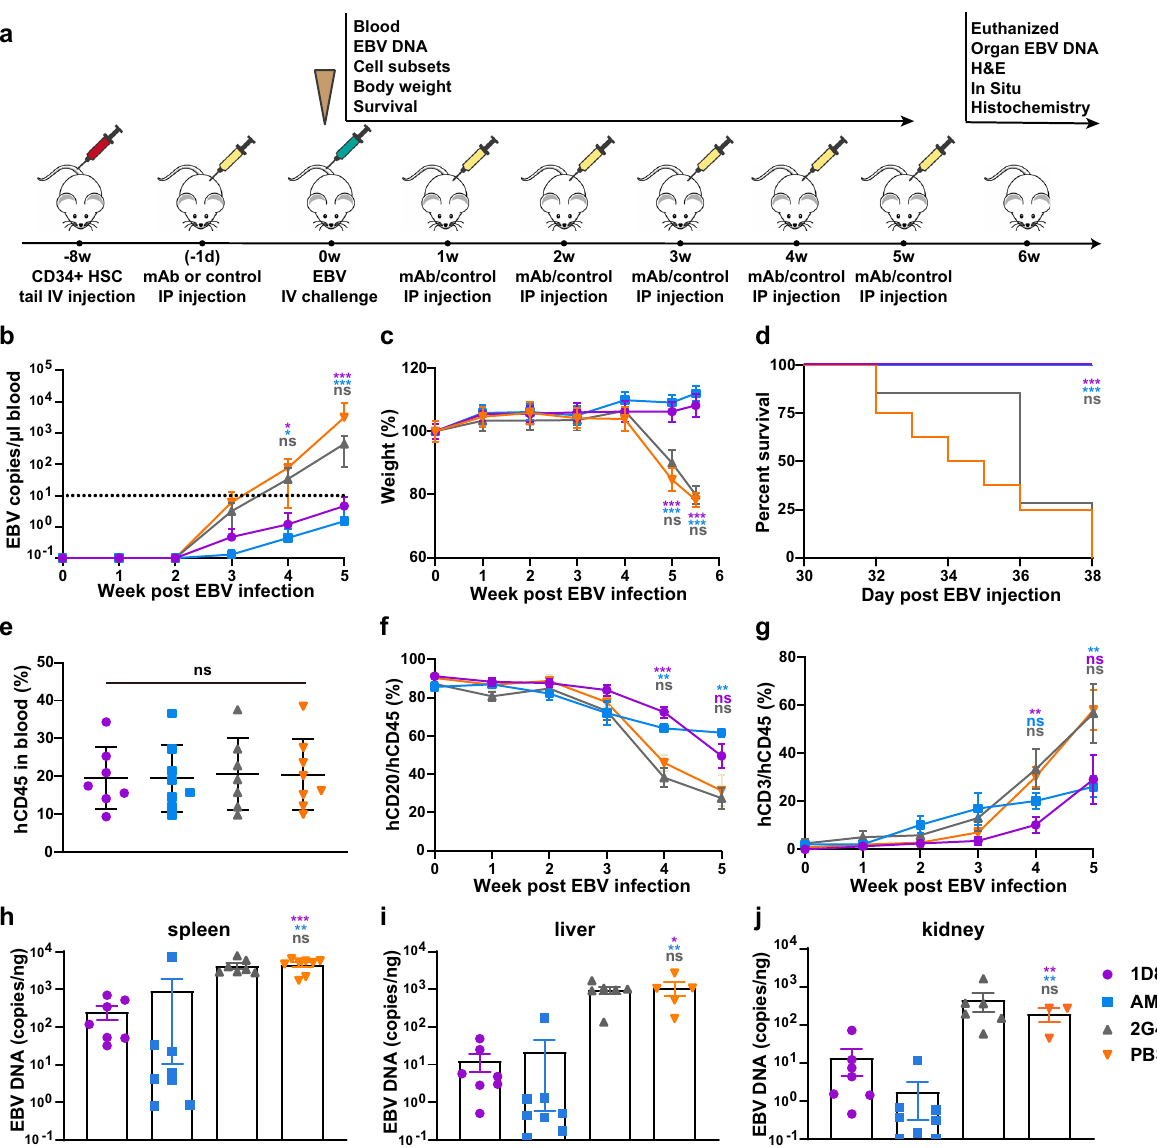
Fig. 2 Protective ef fi cacy of 1D8 against lethal EBV challenge in humanized mice. a Timeline for engrafting CD34 + human hematopoietic stem cells (HSC), antibody administration, viral challenge, and monitoring for various biological and clinical outcomes. 400 μ g of 1D8 ( n = 7), positive control AMMO1 ( n = 8), negative control 2G4 ( n = 7), or PBS ( n = 8) were administered to the humanized mice via intraperitoneal injection either 24 h prior to or weekly for 5 weeks after intravenous challenge with Akata EBV. b EBV DNA in the peripheral blood, ( c ) body weight, and ( d ) survival were monitored weekly. The percent changes in ( e ) hCD45 + , ( f ) hCD20 + , or ( g ) hCD3 + cells over the experiment period. On week 6 post infection, ( h ) virus titers in spleen, ( i ) liver, ( j ) kidney were analyzed. All data are presented as mean ± SEM. * p < 0.05; ** p < 0.01; *** p < 0.001; ns, no signi fi cant, two-tailed